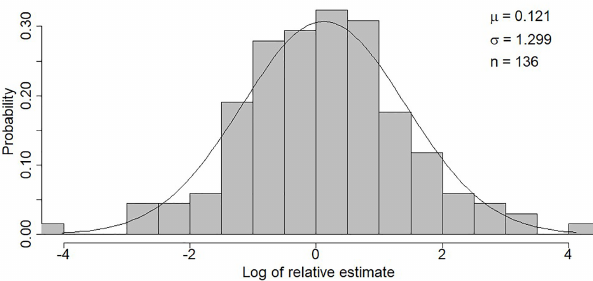
Figure 2. Fit of the normal distribution to the frequency distribution of the log-transformed relative streamflow estimates (ratio of the estimated streamflow and the measured